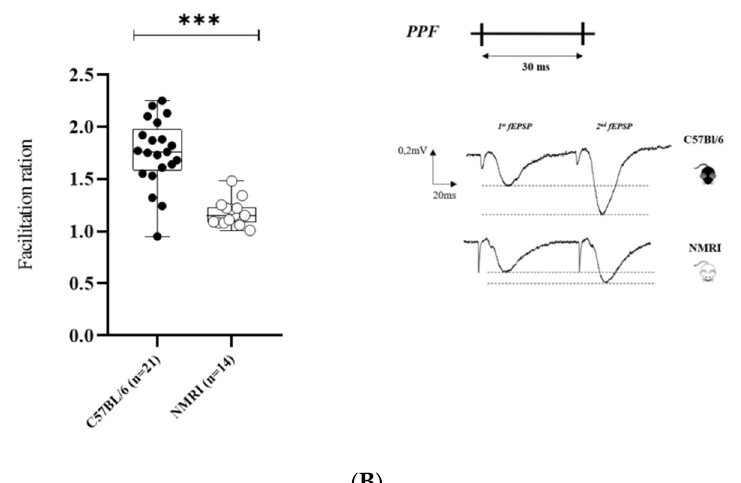
Figure 1. Basal synaptic transmission and paired-pulse facilitation are higher in C57BL/6 than in NMRI. ( A ) Basal synaptic transmission determined by I/O curves in slices from C57BL/6 mice ( n = 20 slices/ n = 14 mice) and NMRI mice ( n = 13). Data are expressed as median ± interquartile. ANOVA for repeated measures (* p < 0.05). ( B ) Facilitation ratio in slices from C57BL/6 mice ( n = 21 slices/n = 14 mice) and NMRI mice ( n = 14 slices/ n = 11 mice) (left). Stimulation pattern of PPF with corresponding representative traces of paired-pulse-induced fEPSP from NMRI and C57BL/6 mice (right). Each 2nd fEPSP slope was divided by the slope of the 1st fEPSP. Data are expressed as median ± interquartile. Mann–Whitney U test (*** p < 0.001).